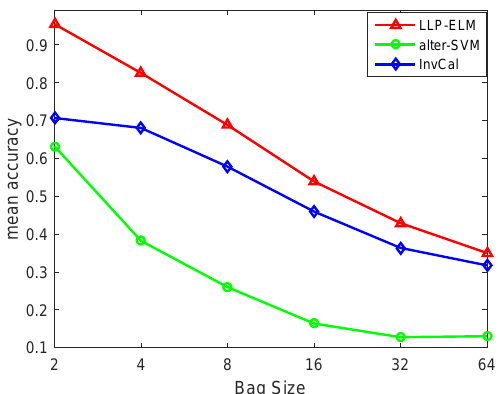
Figure 7. The performance of different methods on Caltech-101, where the x-axis is bag size and y-axis represents the accuracies of different algorithms. Furthermore, red, blue and green lines denotes the LLP-ELM, InvCal and alter- ∝ SVM